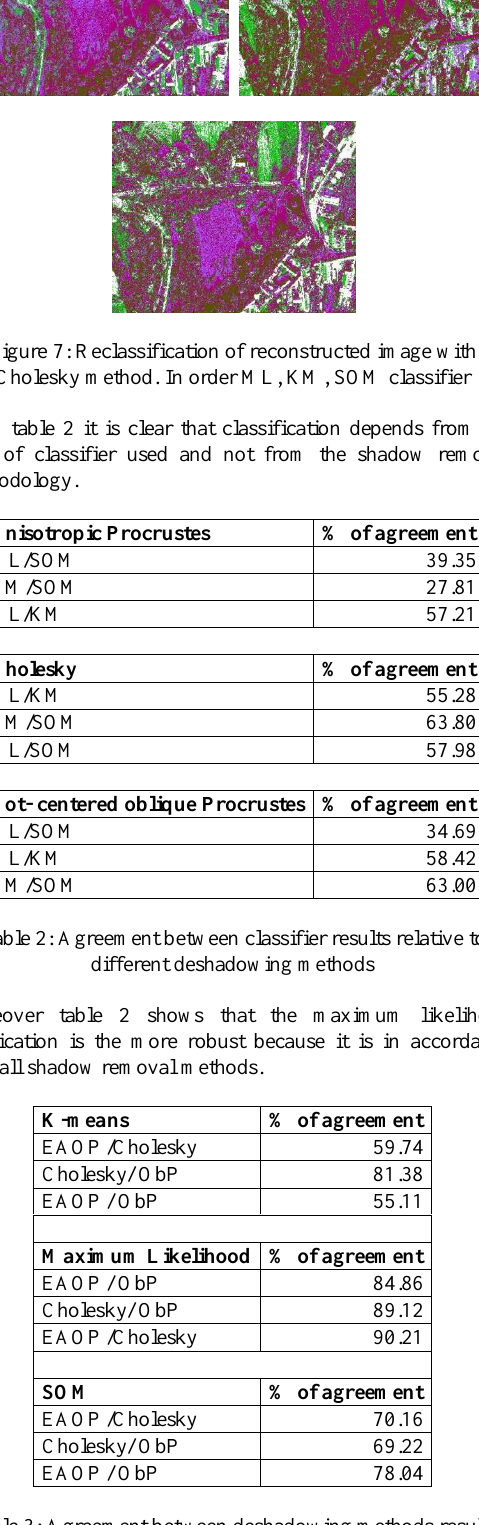
Table 3: Agreement between deshadowing methods results relative to different classification